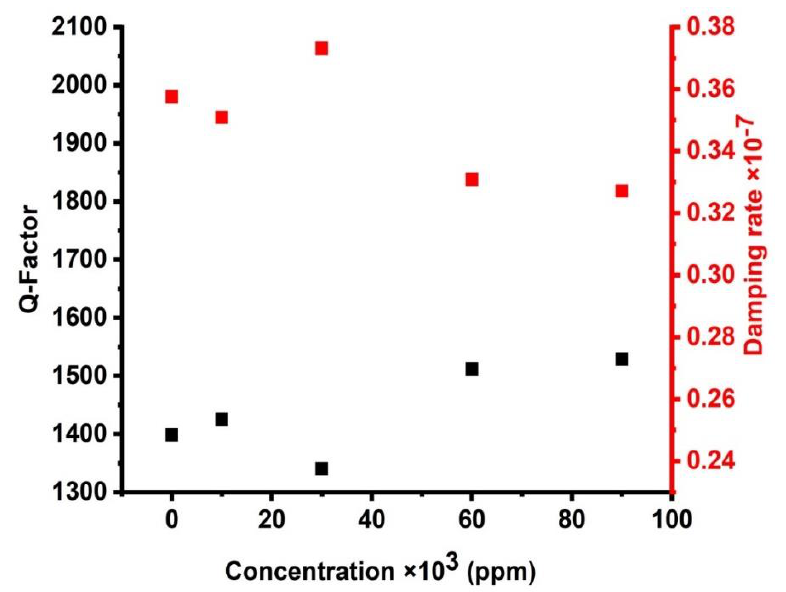
Figure 11. The effect of cadmium bromide concentrations on the quality factor and damping rate of the cadmium bromide